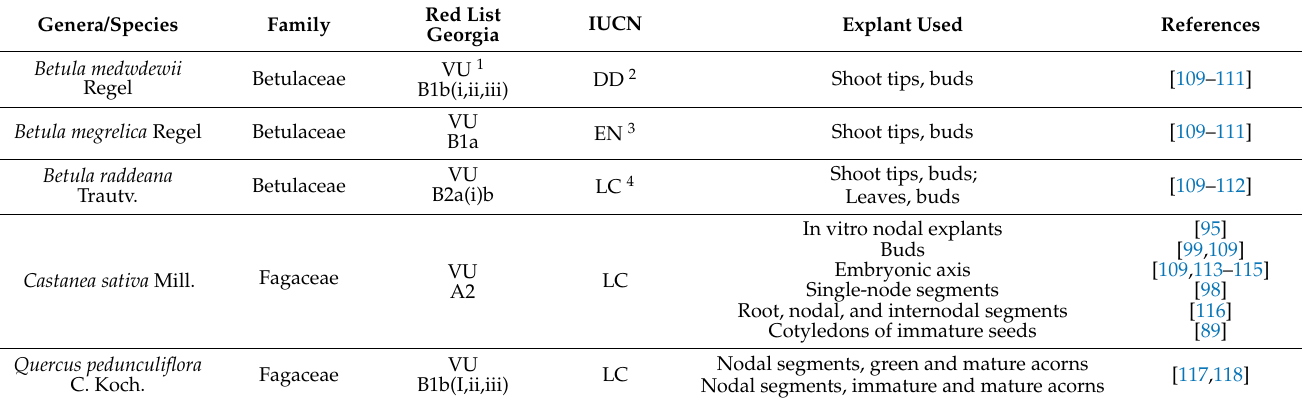
Table 1. Conservation status and in vitro propagation of some threatened woody species of Georgia.